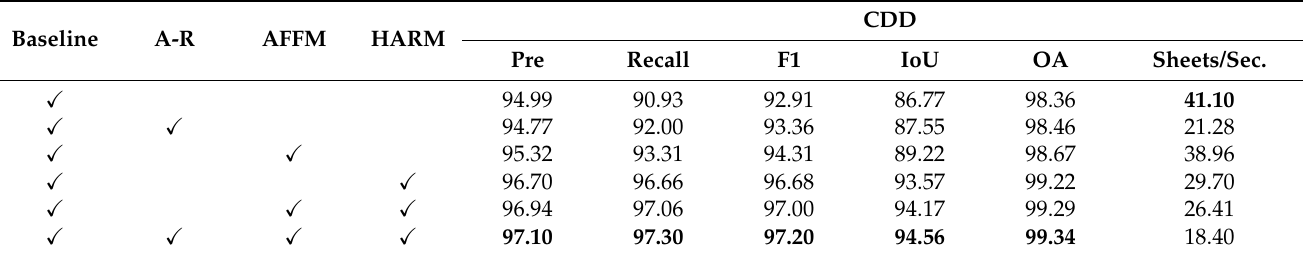
Figure 12. Comparison of attentional heat maps before and after baseline model improvement. ( a ) T1 image, ( b ) T2 image, ( c ) ground truth, ( d ) attentional heat map generated by the baseline model UNet++, ( e ) attentional heat map generated by HARNU-Net. Table 5. Ablation experiments of the modules in our model on the CDD dataset and the speed of change map generation. The highest score is marked in bold. The five evaluation metrics are expressed in percentage